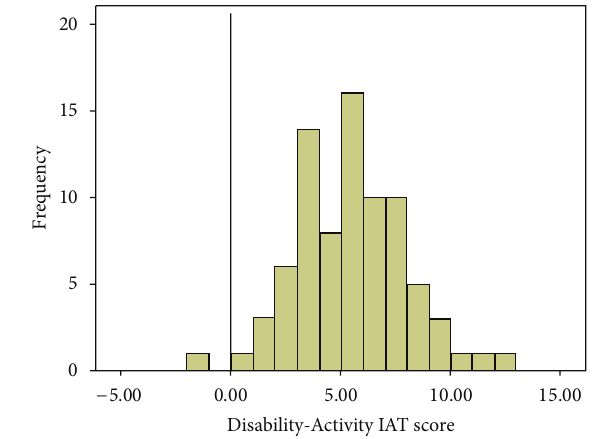
Figure 3: Frequency of Disability-Activity IAT scores. Vertical line represents a score of zero, the score associated with no exerciser stereotype. Negative score represents negative attitudes towards people with a physical disability who are inactive positive score representspositiveattitudestowardspeoplewithaphysicaldisability who are